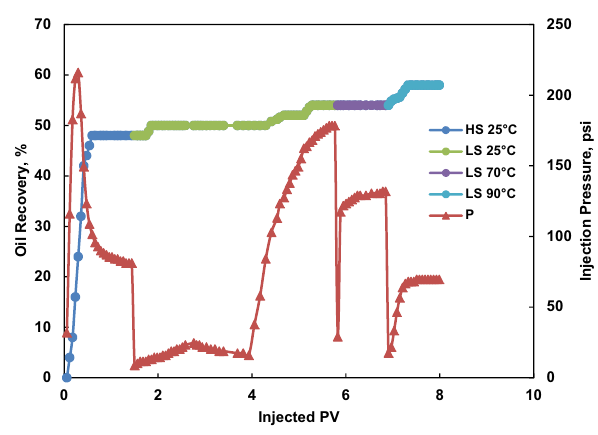
Fig. 2 Oil recovery factor and pressure profile for core#1, which was sequentially flooded by HS water/LS water at 25, 70, and 90 °C